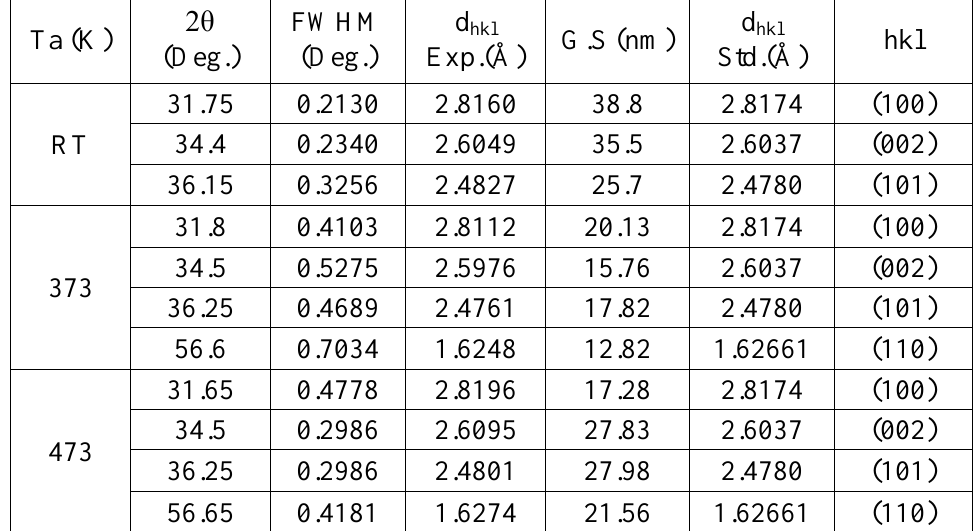
Fig.1: XRD patterns of ZnO thin films at different annealing temperatures (as deposited, 373, 473) K. Table 1: XRD parameters of ZnO thin films at different annealing temperatures (as deposited, 373, 473)